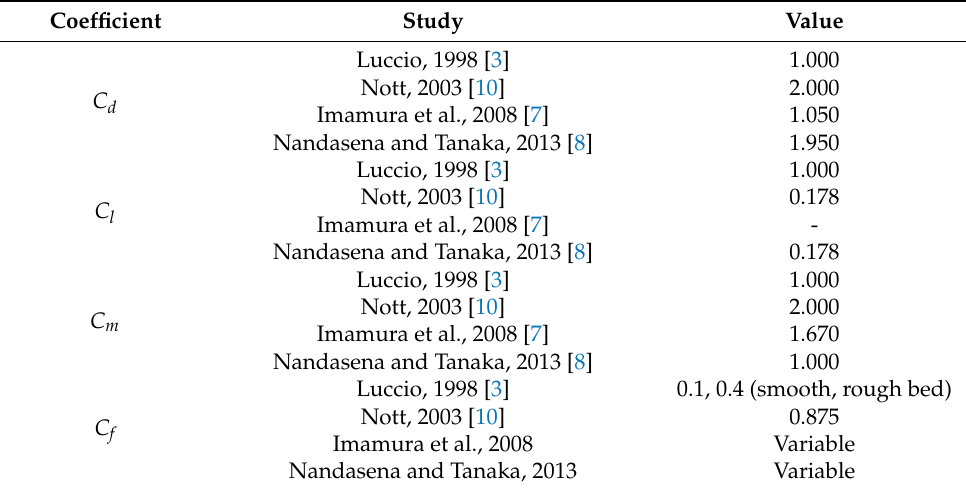
Figure 1. Schematic of the forces acting on an object resting on a sloping beach face and moment arms for uprush and backwash. In magenta (blue) the forces that act as destabilizing (stabilizing) in the momentum balance equation. Table 1. Drag, lift, added mass and friction coefficients adopted by several studies investigating the mobility of objects on a sloping